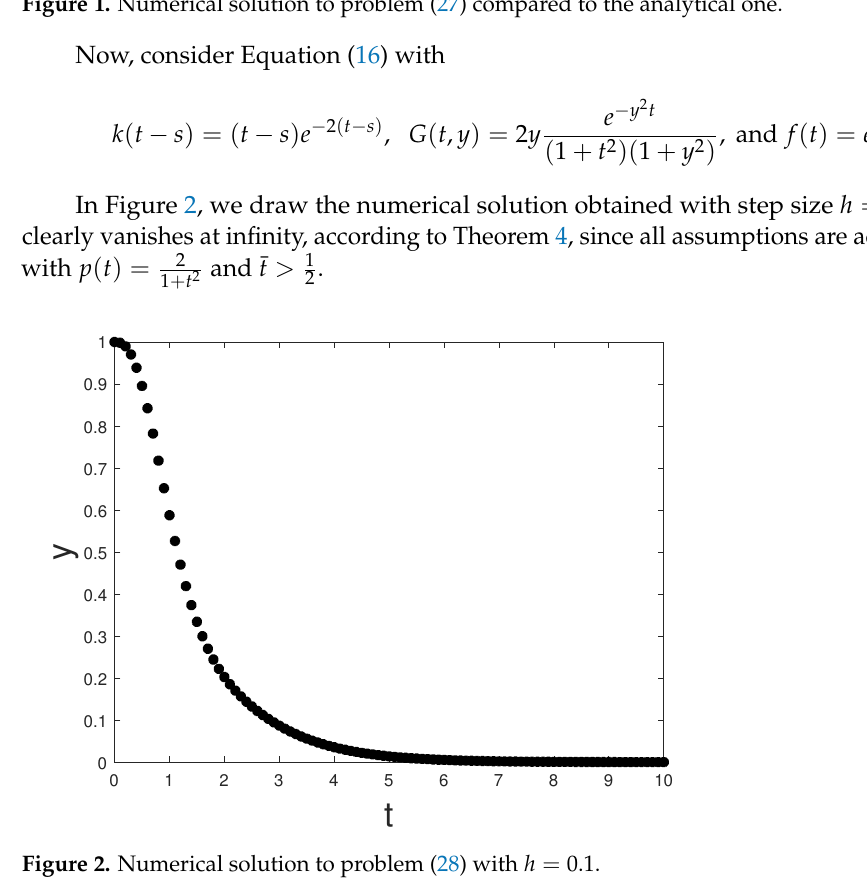
Figure 1. Numerical solution to problem (27) compared to the analytical one.